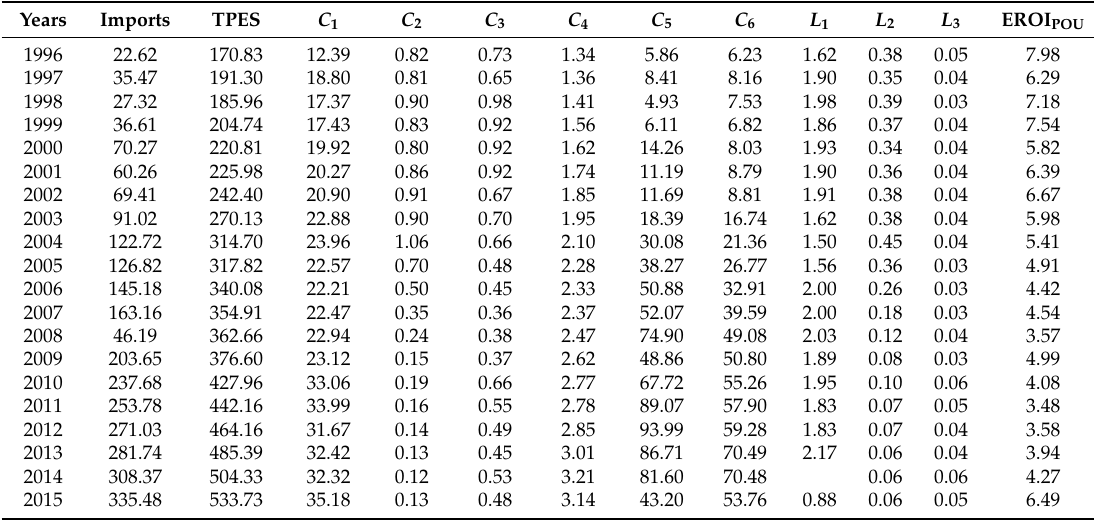
Table A2. Data for calculate EROI POU of oil in China (units: